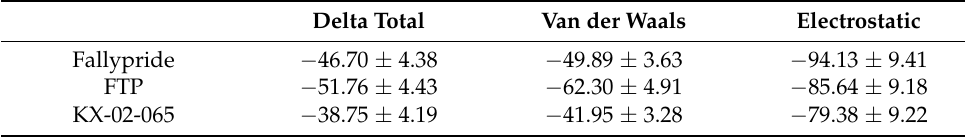
Table 1. Summary of MM/GBSA binding free energy